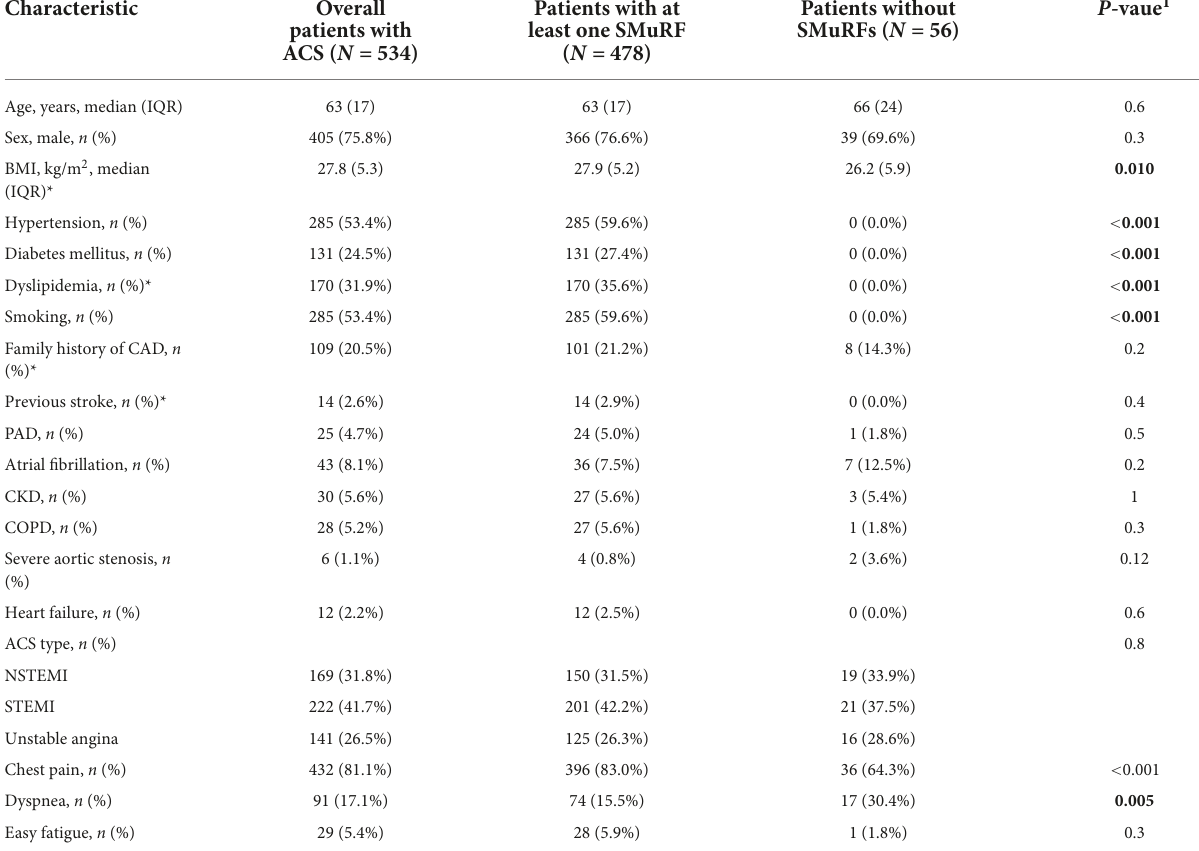
TABLE 1 Baseline clinical and demographic characteristics of the included